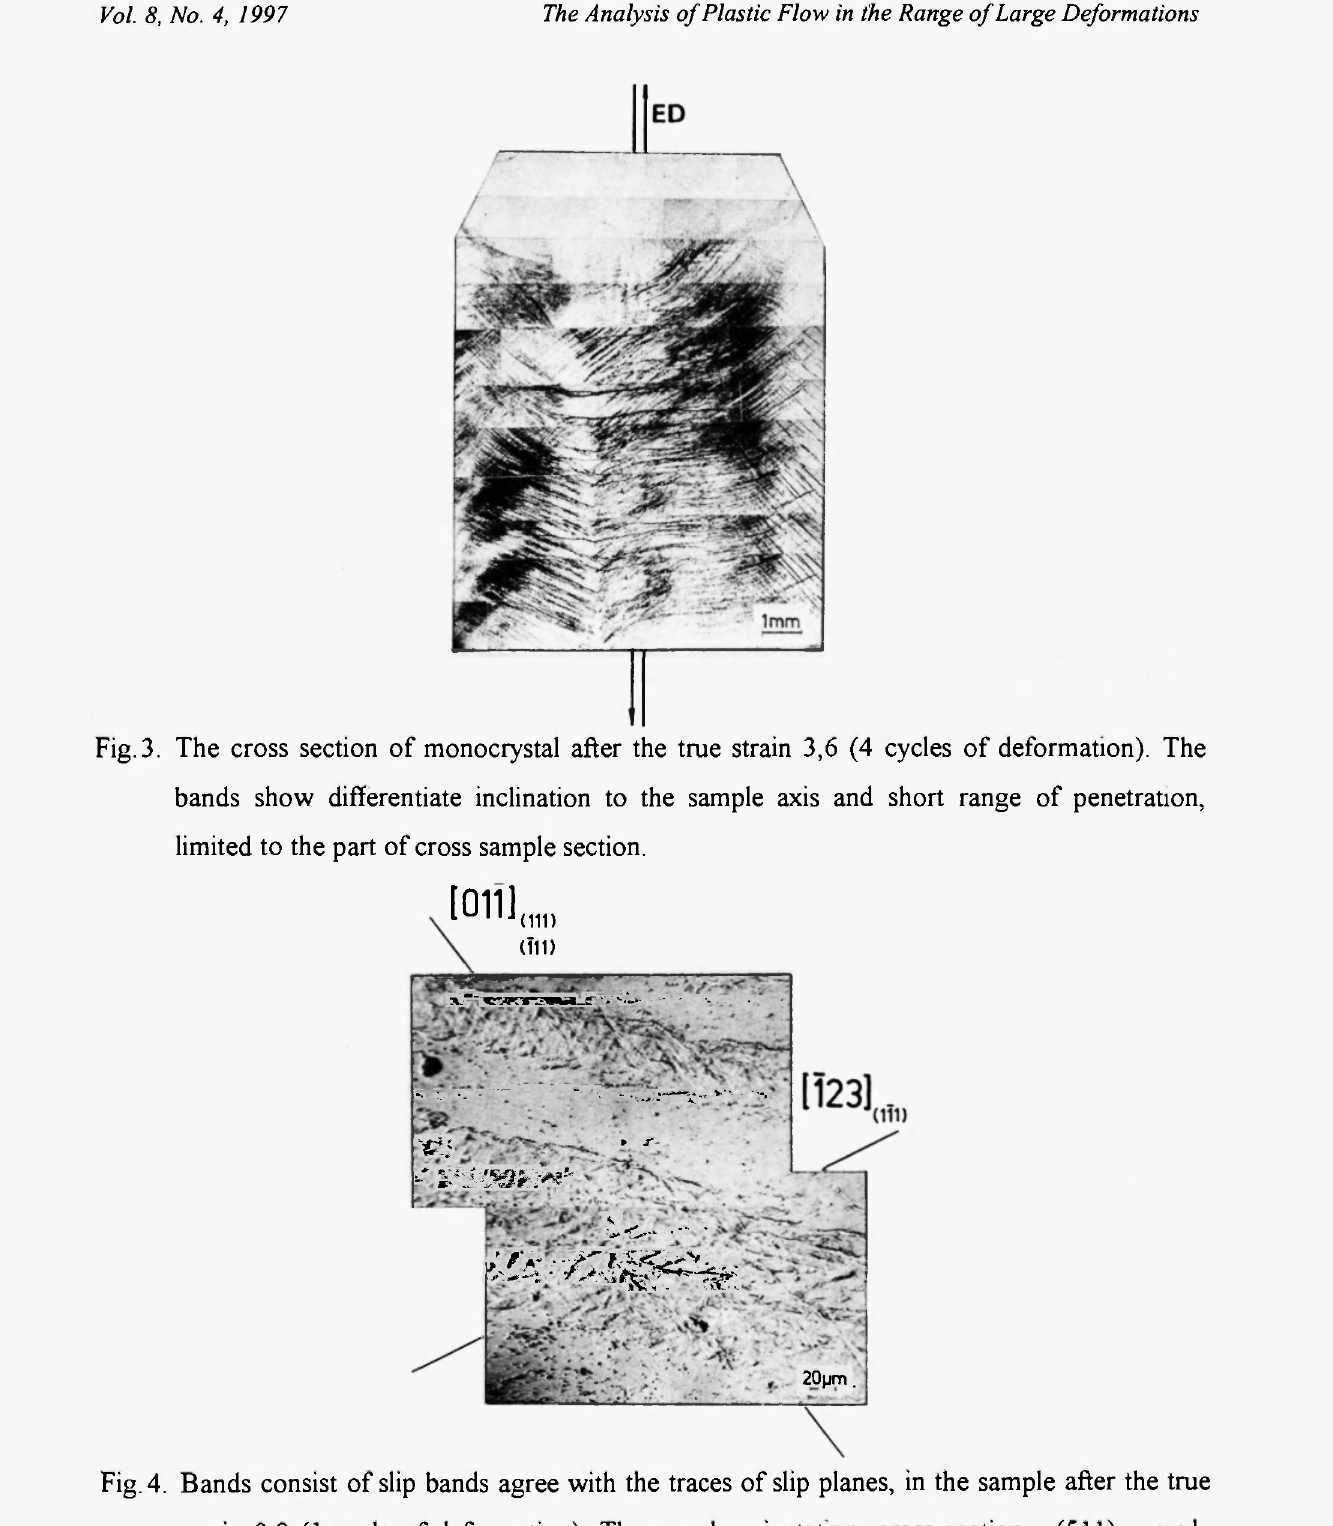
Fig. 4. Bands consist of slip bands agree with the traces of slip planes, in the sample after the true strain 0,9 (1 cycle of deformation). The sample orientation: cross section - (511), sample axis - 127